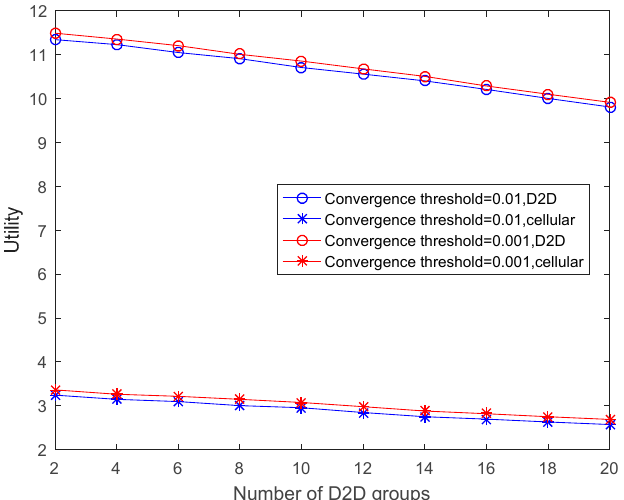
Figure 8. D2D and cellular’s utility with di ff erent convergence thresholds, M = 20